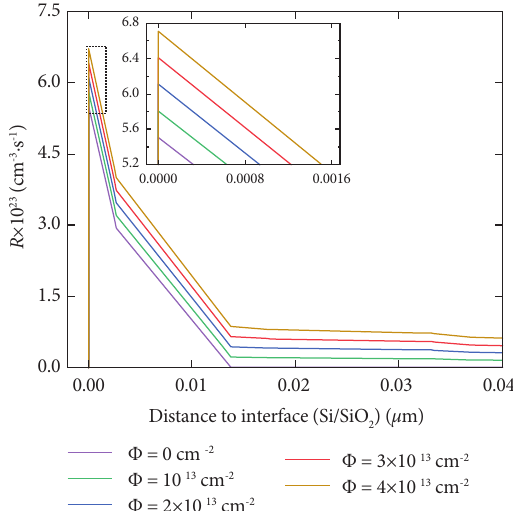
Figure 8: The influence of DD effects on the carrier recombination rate of TID